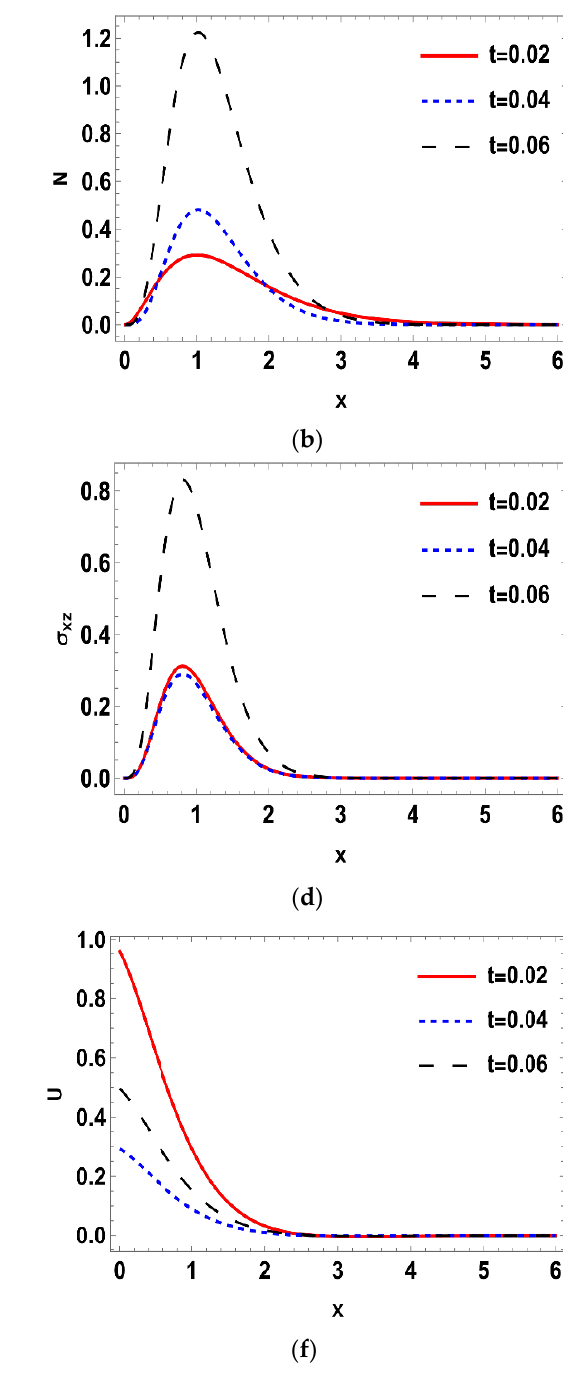
Figure 6. ( a – f ) The variance of temperature, normal stress, carrier density, displacement and heat conduction distributions around its mean at different values of times t = 0.2, t = 0.4 and t = 0.6, when a =